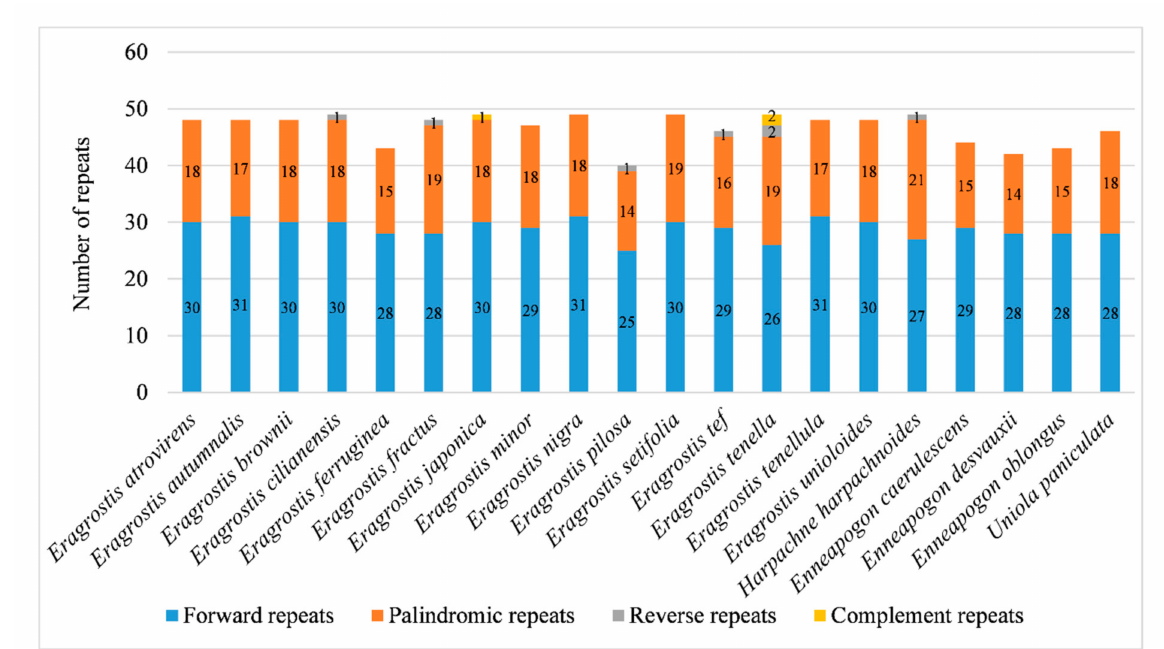
Figure 2. The number of four repeat types in 20 Eragrostideae chloroplast genomes.